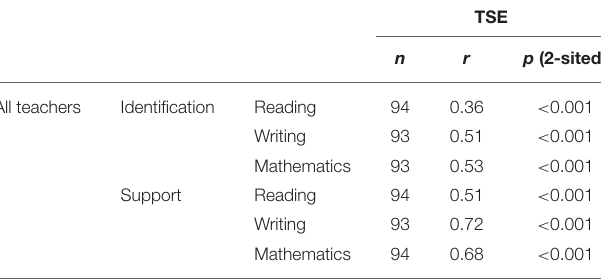
TABLE 10 | Correlations between identification of difficulties as well as support of students with difficulties in reading, writing, and mathematics and TSE in distance